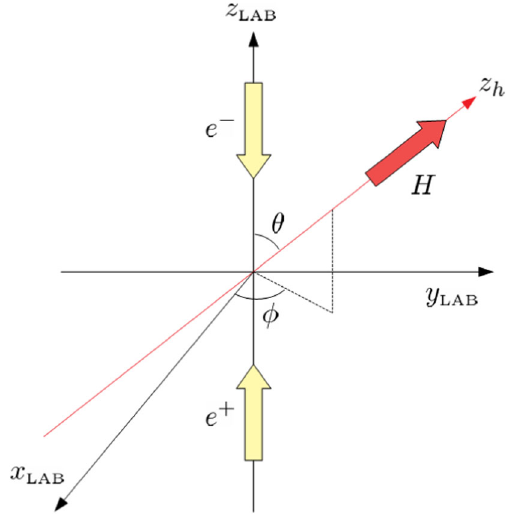
Fig. 15 The LAB frame and the h -frame are both c.m. frames, but differ by a spatial